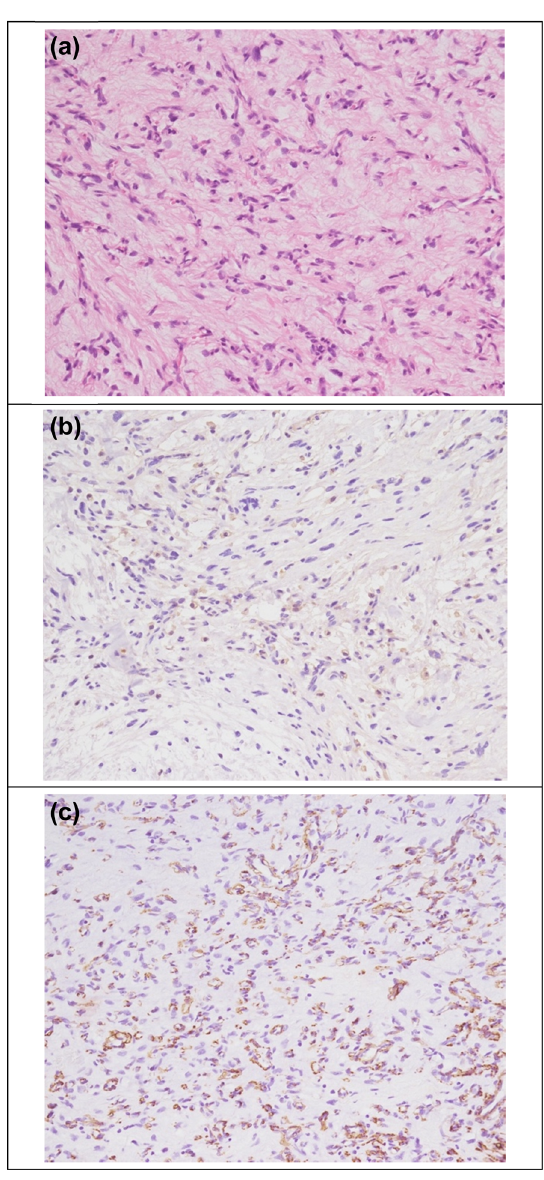
Figure 3: Typical bland spindle or stellate cells with little or no nuclear polymorphism and variably elongated cytoplasm set in a mucomyxoid stroma. Vascularity was variably composed of delicate to more hyalinized vessels ( a ) ( hematoxylin and eosin, magni fi ca - tion 200 ×) ; typical cytoplasmic desmin ( b ) and smooth muscle actin ( c ) immunopositivity ( magni fi cation 200 ×)